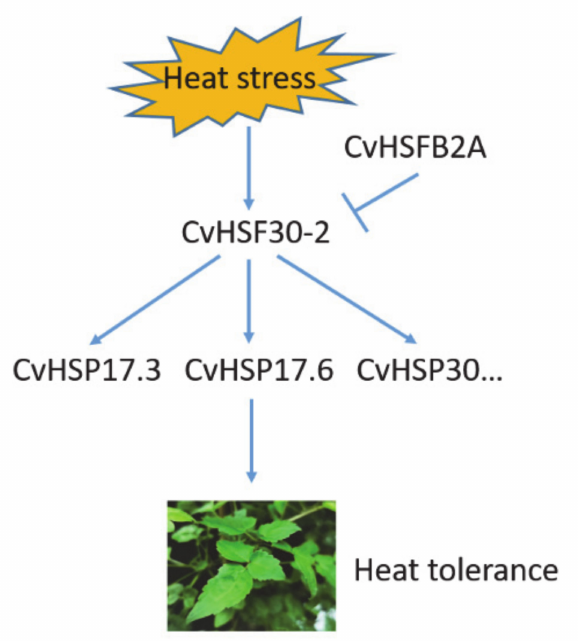
Figure 8. Working model for Clematis vitalba